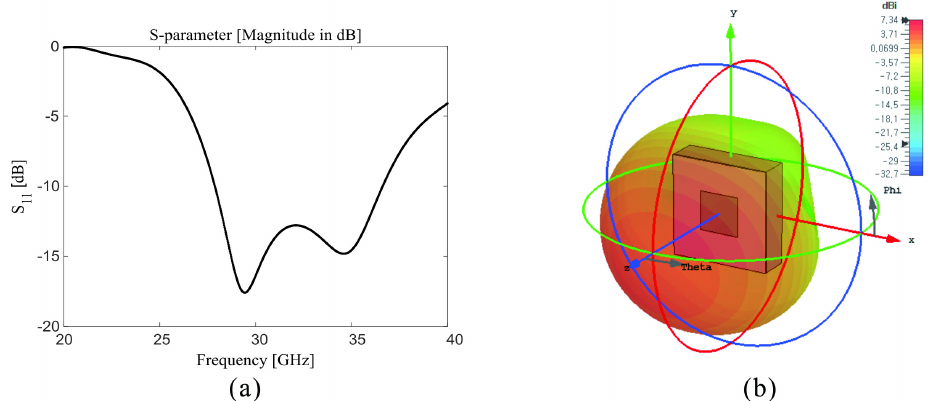
Figure 9. Simulated S 11 and 3-D radiation pattern of a cavity-backed patch antenna: ( a ) S 11 , ( b ) 3-D radiation pattern.